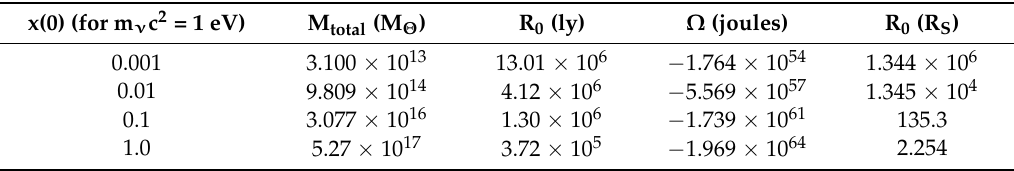
Table 1. Hydrostatic solutions for degenerate neutrino matter.